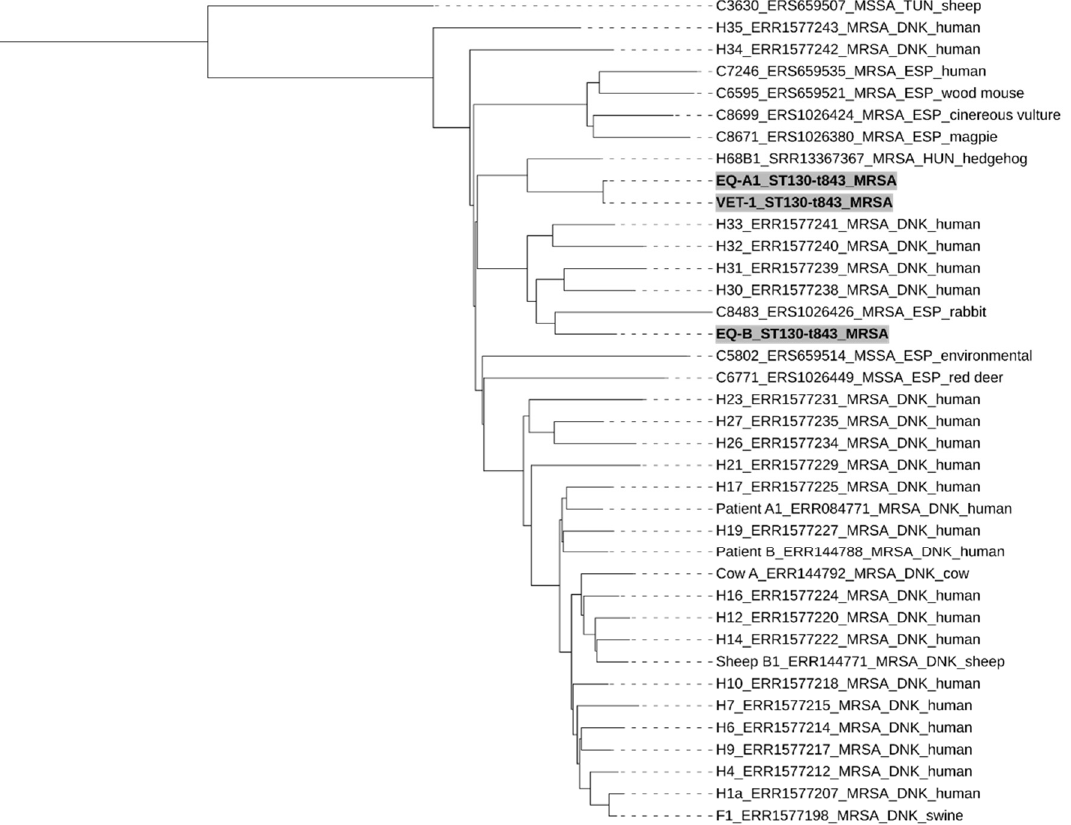
Figure 3. Neighbour-joining tree of CC130 S. aureus isolates. Genetic relationship between the two equine (EQ-A1, EQ-B) and the human (VET-1) originated from mecC -positive isolates from Hungary (highlighted with grey background), in comparison to other selected 32 mecC -positive MRSA and three MSSA CC130 isolates from Europe (Denmark (DNK), Hungary (HUN), Spain (ESP), and Tunisia (TUN). The scale bar indicates the number of differing alleles and is equivalent to 100 allele differences. (For further details, see Appendix A and Table S3).